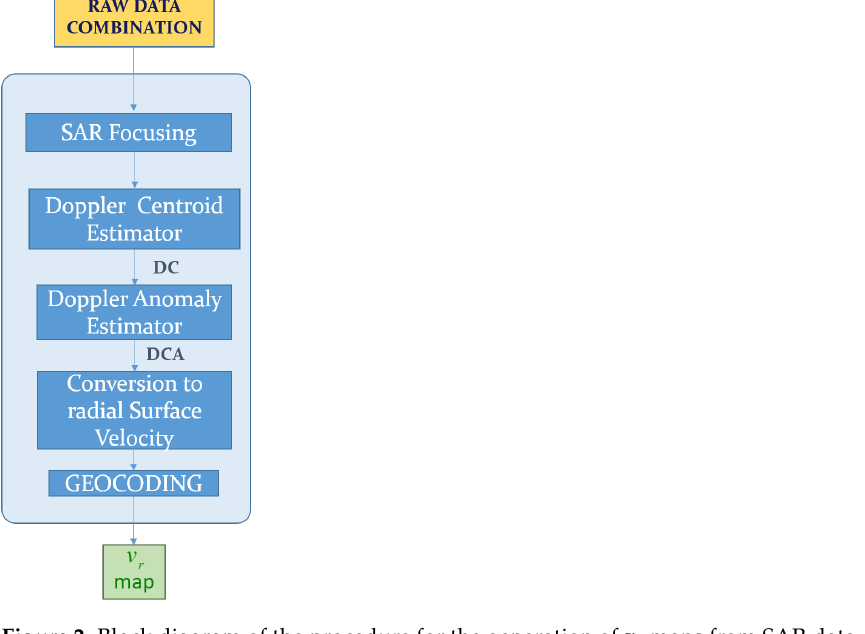
Figure 2. Block diagram of the procedure for the generation of v r maps from SAR